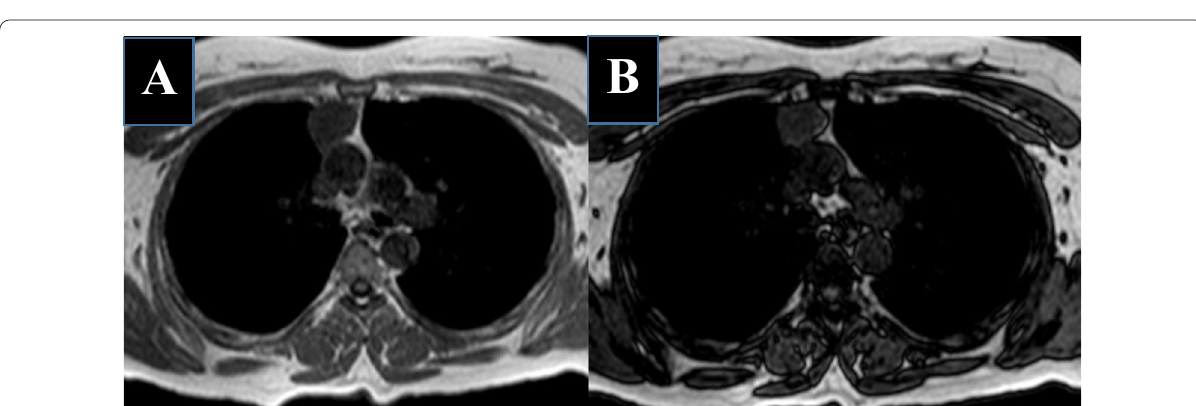
Fig. 4 MRI chemical shift imaging in a 40‑year‑old female patient complaining of drooping of both eyelids and dysphagia diagnosed as MG. a In phase and b out of phase MR images show the mass eliciting intermediate signal to the surrounding muscles with no apparent signal drop in the out of phase series. CSR value is 1.01. Histopathological diagnosis was